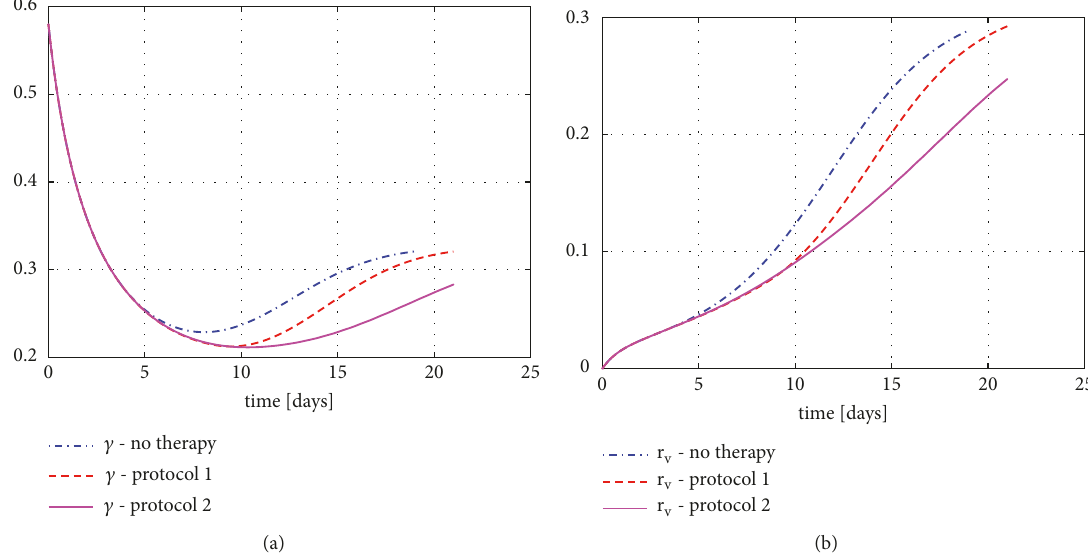
Figure 4: (a) Ratio of the well-supported tumor cells ( 𝛾 ) in the case of various therapies; (b) vascularization ratio ( 𝑟 V ) in the case of various therapies.